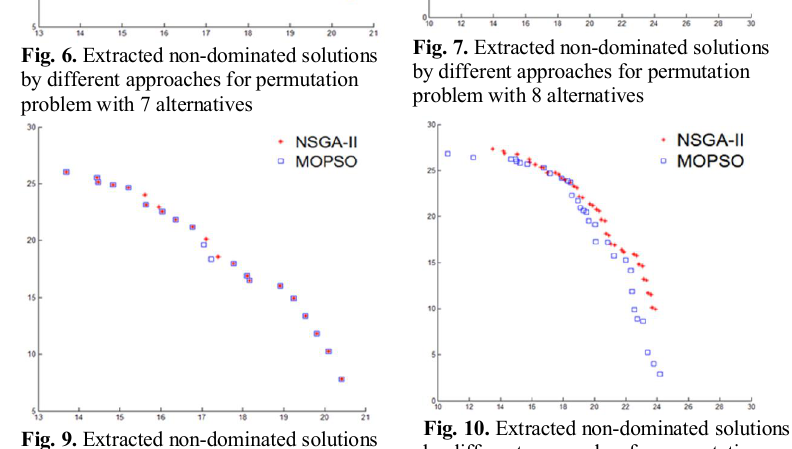
Fig. 8. Extracted non-dominated solutions by different approaches for permutation problem with 9 alternatives